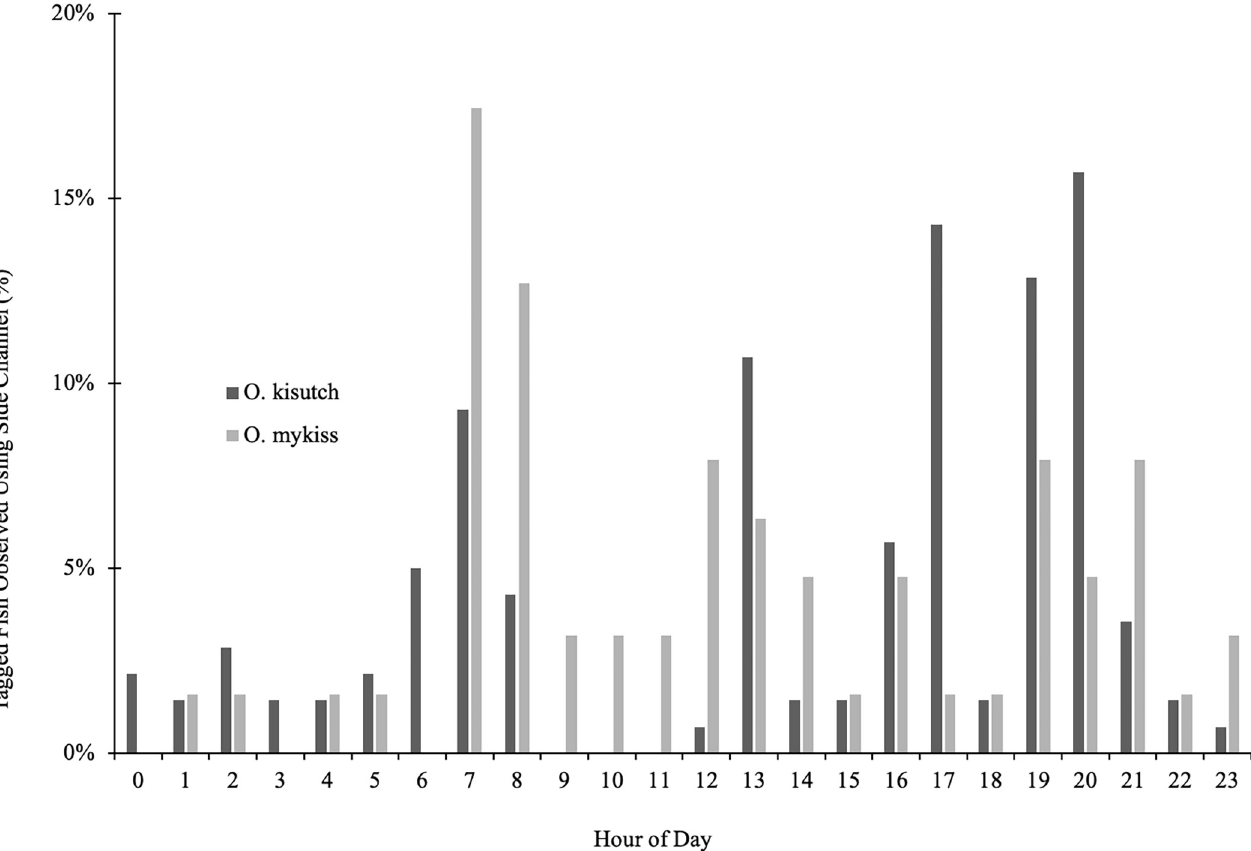
Fig 10. The hourly timing of juvenile salmonids jumping over BDAs in 2017. Hourly timing of jumping over BDAs by juvenile coho salmon ( O . kisutch ) and steelhead trout ( O . mykiss ) in 2017, as a percentage of tagged fish (coho n = 155; steelhead n = 39). Coho salmon jumped more frequently during the day, while the majority of steelhead jumping occurred at night. Sunrise = 07:34 and sunset = 18:17 on October 24 th , 2017.